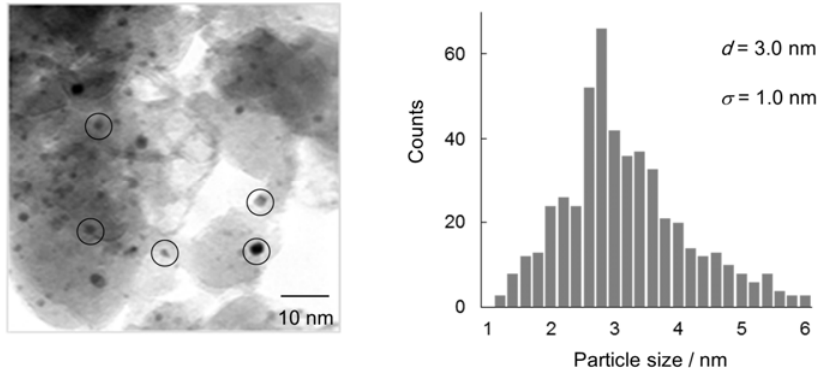
Figure 3. TEM image and size distribution of Au NPs of Au/HT after reuse